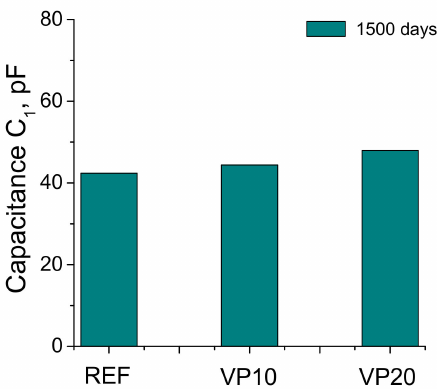
Figure 6. Results of capacitance C 1 for the mortar series studied.